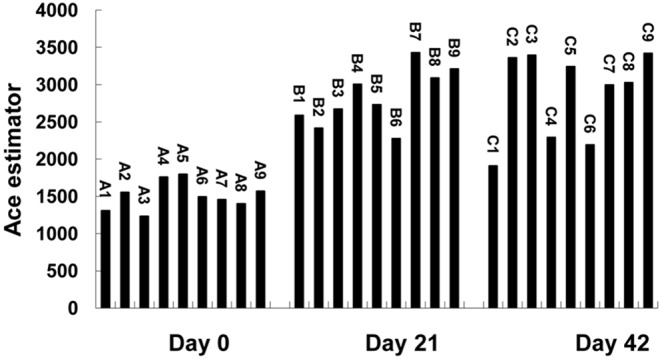
Ace estimator of each treatment in different fermentation time.